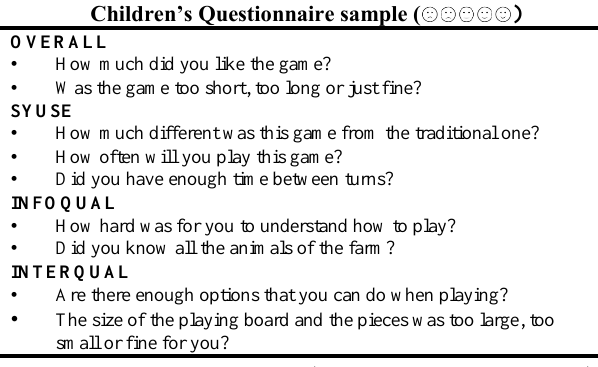
Table 2: Indicative questionnaires for each group Children’s Questionnaire sample